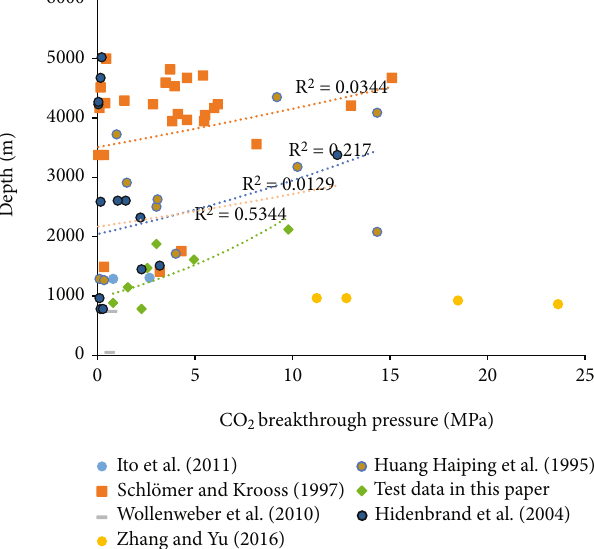
Figure 8: Relationship between CO